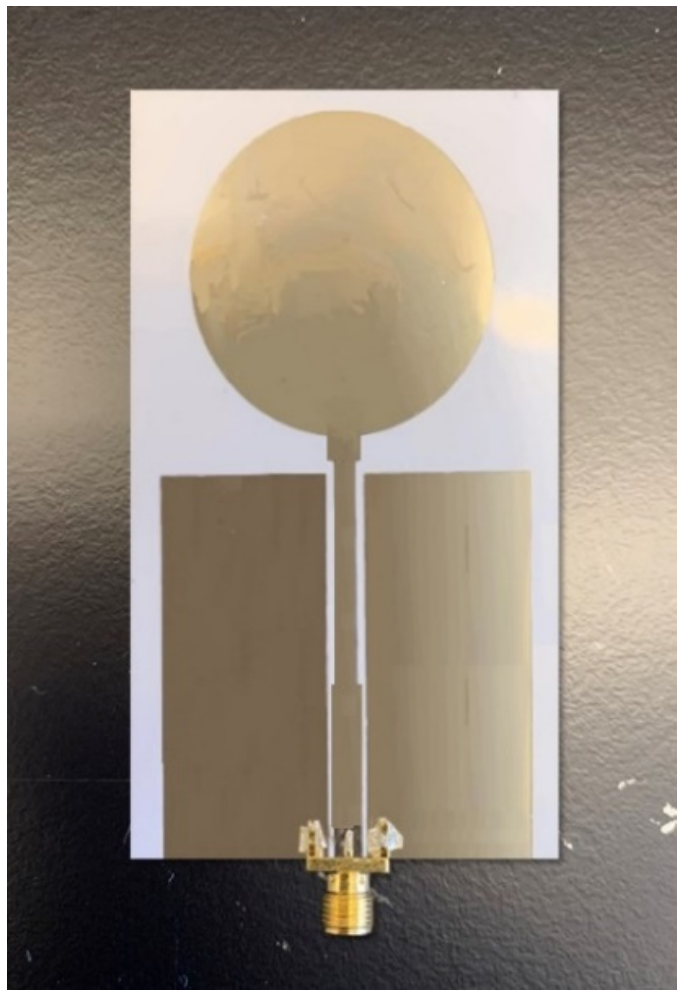
Figure 6. Inkjet-printed UWB antenna.